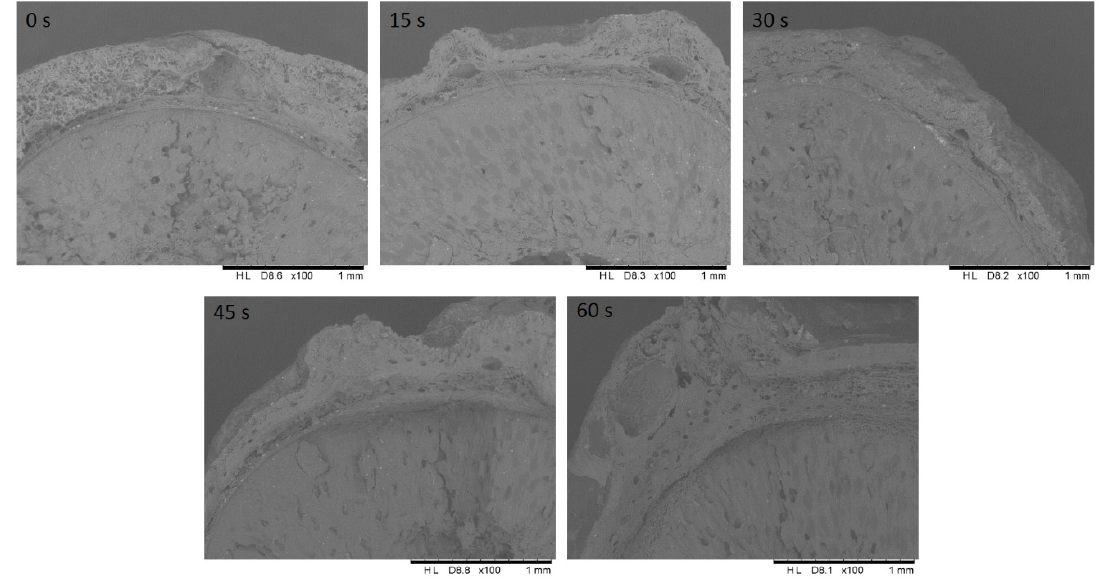
Figure 8. Scanning electron microscope(SEM) images of plasma treated black pepper seeds.